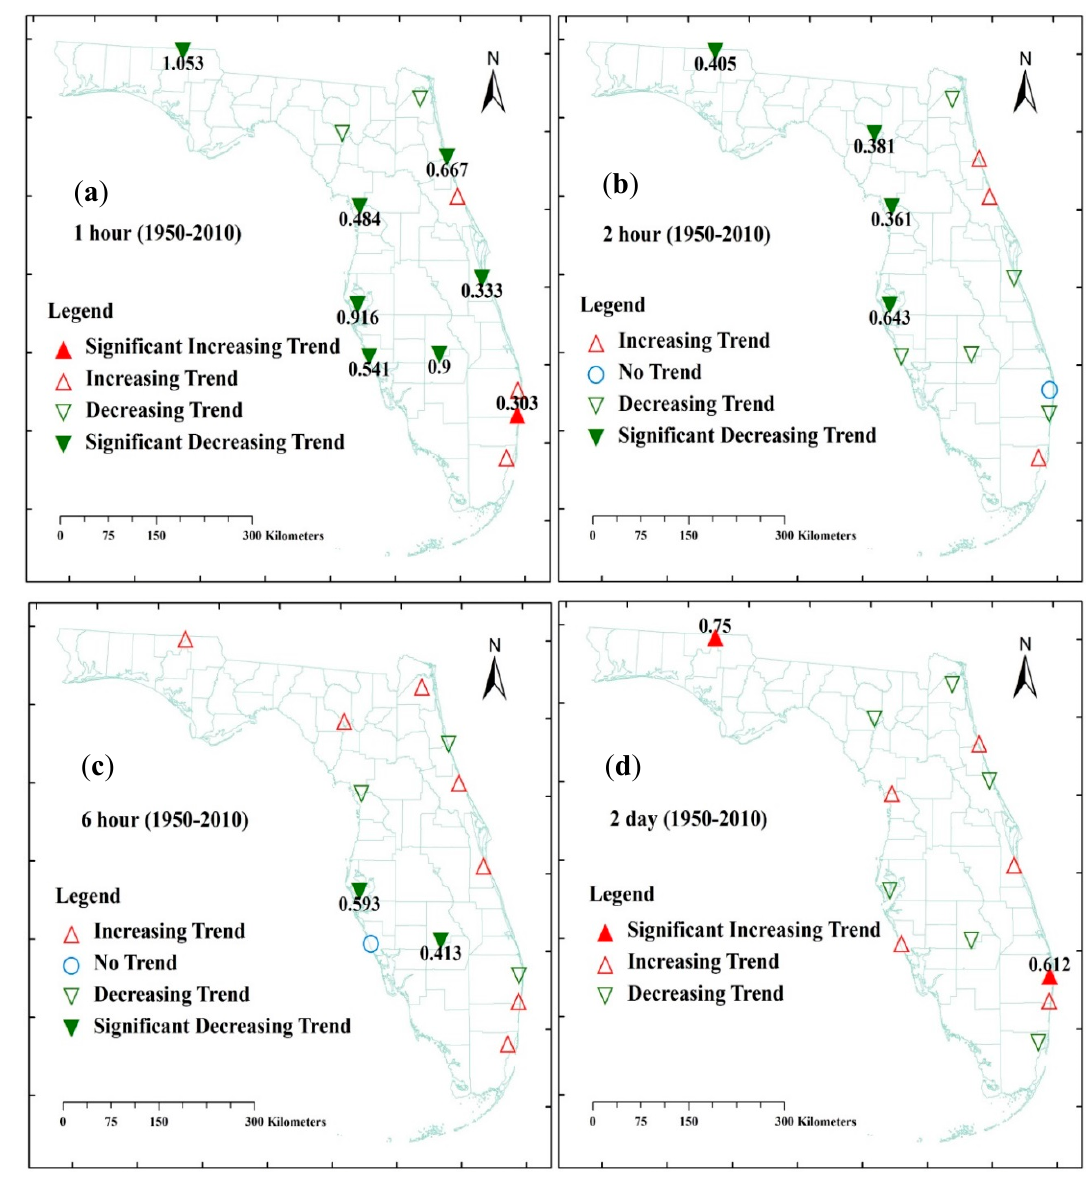
Figure 5. Spatial pattern of the trend results for the annual number of above-threshold events for ( a ) 1 h, (b ) 2 h, ( c ) 6 h, and ( d ) 2 day rainfalls during the 1950–2010 analysis period. The slope value (events/year) for locally significant trend is also indicated.